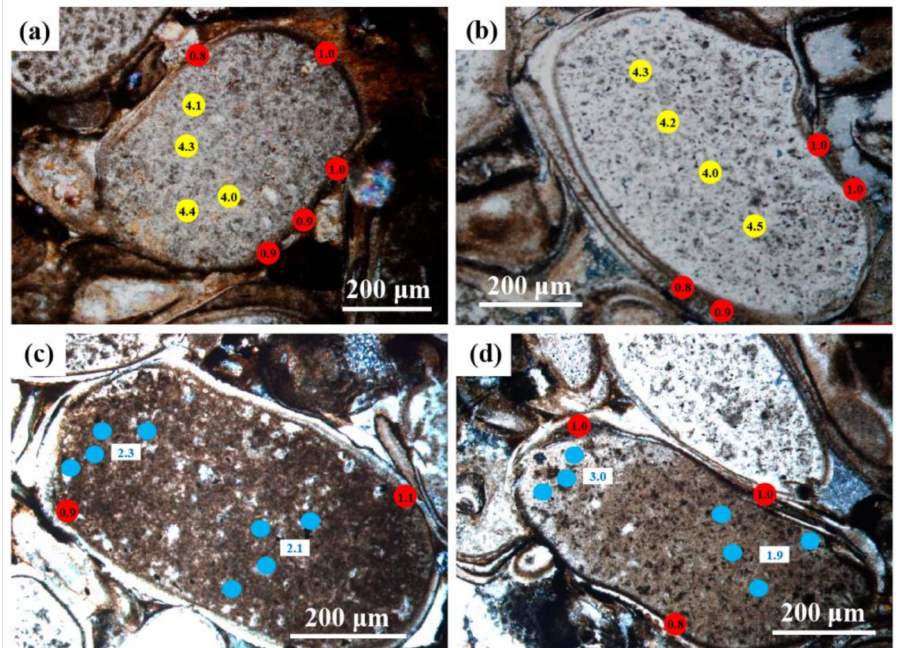
Figure 7. In situ δ 13 C values of calcified shells and filling ankerites determined by using LA-IRMS. ( a , b ) are the ostracods filled with ankerite. ( c , d ) are the ostracods filled with chlorite. The red, yellow, and blue dots are ablation points in the experiment. Data in red and yellow dots are δ 13 C values of calcified shells and ankerites, respectively. Data beside the blue dots are mixed δ 13 C values of ankerite from neighbor ablation